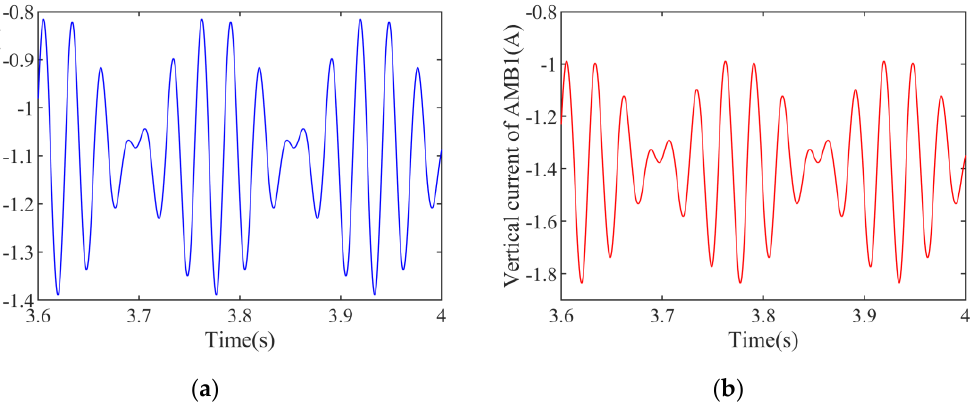
Figure 12. Current in the vertical direction of the AMB 1 ( ω i = 200 rad/s; F L = 200 N). ( a ) The conventional MSDS. ( b ) The nonlinear MSDS.